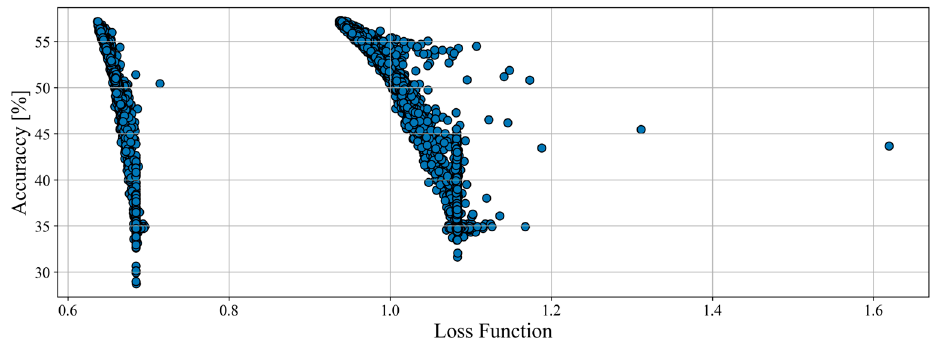
Figure 7. Accuracy and value of loss function of params combinations examined during the hyperparameters optimization process for loaders.